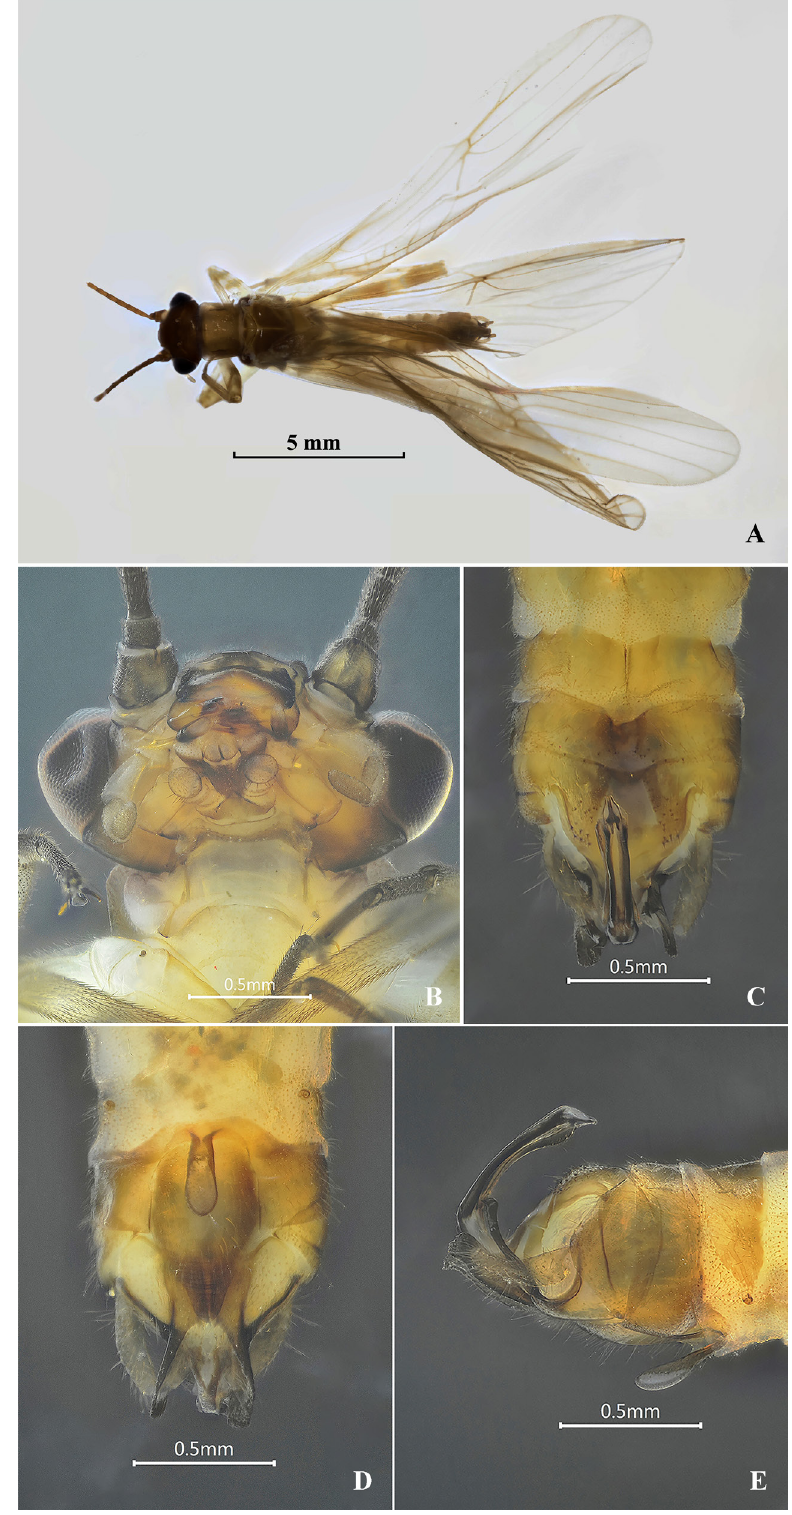
Fig. 1. Indonemoura yingjiangensis Bai & Qian sp. nov., holotype, ♂ (SWFU). A . Habitus, dorsal view. B . Head and prothorax, ventral view. C . Terminalia, dorsal view. D . Terminalia, ventral view. E . Terminalia, lateral